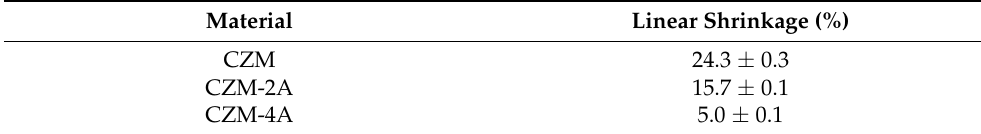
Table 3. Linear shrinkage of the